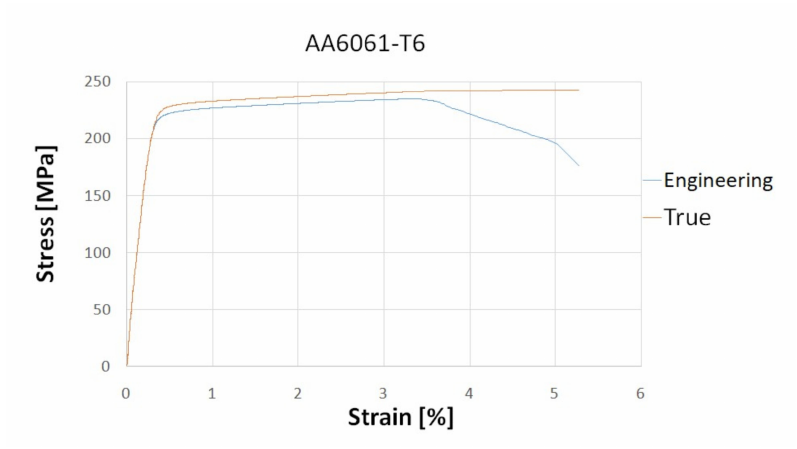
Figure 6. Stress–strain curve for aluminium alloy.